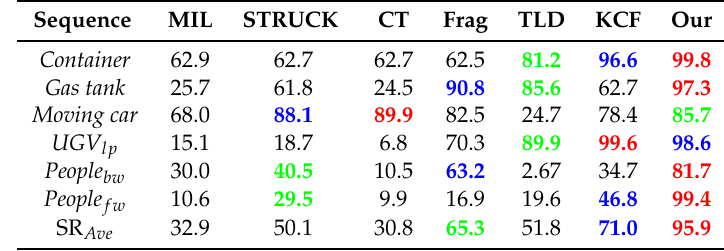
Table 4. Success rate (SR) (%) ( ξ = 0.5). Red, blue and green fonts indicate the best, second best and third best performances in all visual trackers. The total number of evaluated image frames in this paper is 11,646.